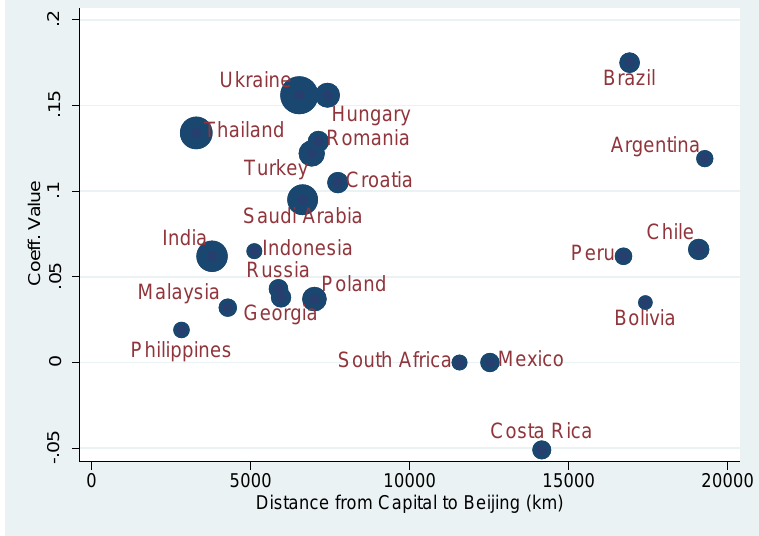
Figure 2 : Weak correlation between location and benefits from imports from